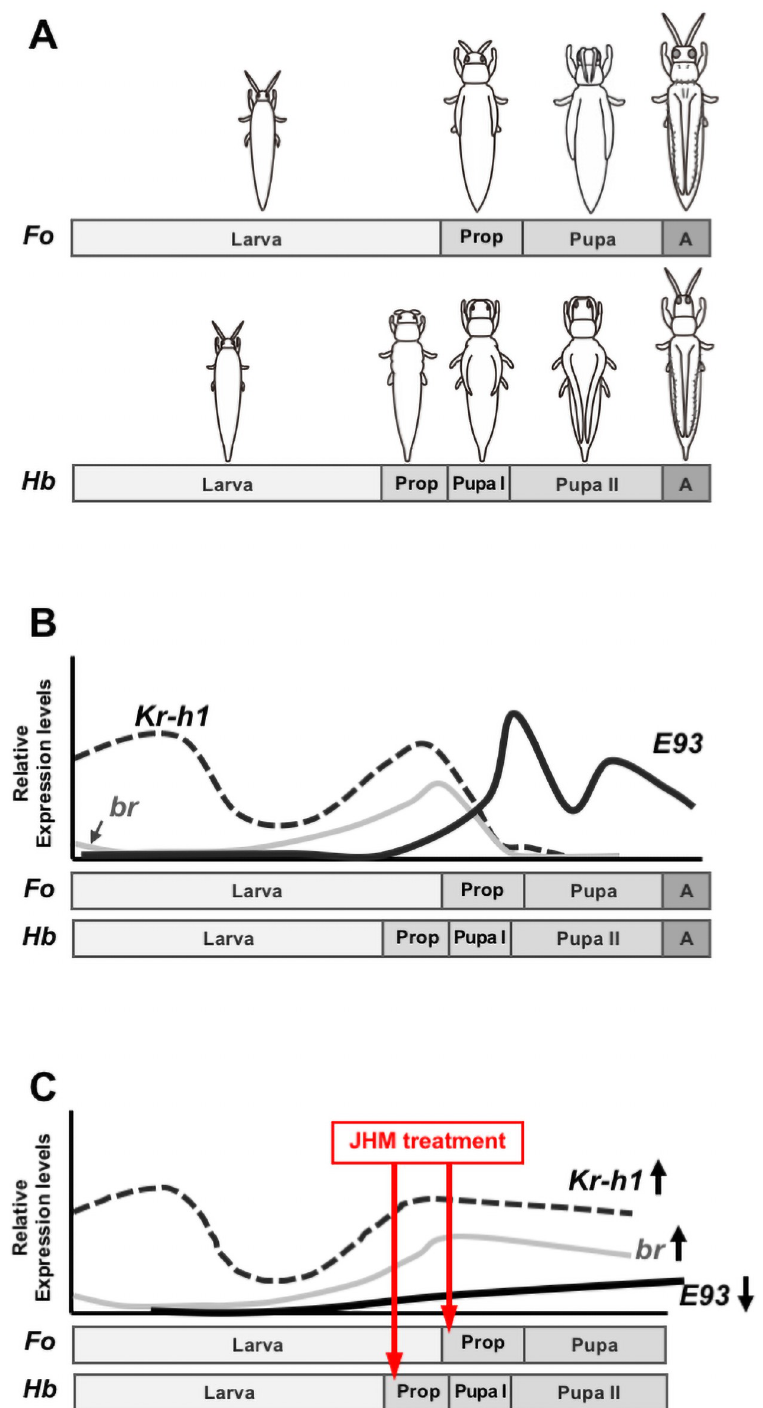
Fig 3. Diagram of the expression profiles of the selected transcription factors in thrips. (A) Postembryonic development of the two thrips species, Frankliniella occidentalis (abbreviated as Fo ) and Haplothrips brevitubus ( Hb ). (B and C) Diagram of the expression profiles of br , Kr-h1 , and E93 . The expression patterns of br and Kr-h1 were illustrated based on our previous report (Minakuchi et al., 2011) [31]. (B) In normal thrips, E93 levels increase as Kr-h1 and br levels decrease. (C) After exogenous JHM treatment at the onset of metamorphosis, the expression of Kr-h1 and br is prolonged, whereas E93 induction is